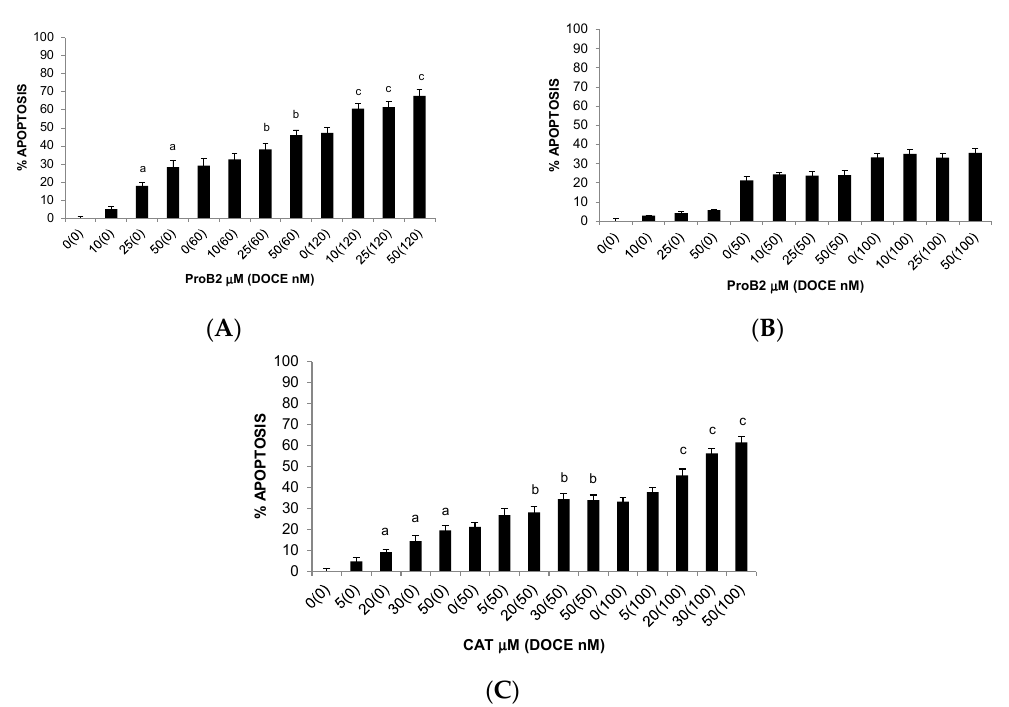
Figure 8. DAPI assay results showing apoptosis of MCF-7 ( A ), T47D ( B ) and MDA-MB-231 ( C ) cells under different concentrations of the test compound (CAT, DOCE, CAT + DOCE) at 72 h. Columns, mean; bars, SE ( n = 3). a represents the significant difference between CAT treatment alone and control treatment; b represents the significant difference between combination treatment (CAT + DOCE 50 nM or DOCE 60 nM) and low-dose DOCE alone; c represents the significant difference between combination treatment (CAT + DOCE 100 nM or DOCE 120 nM) and high-dose DOCE alone ( p < 0.05; one-way ANOVA). Abbreviations: CAT, catechin; DOCE, docetaxel.